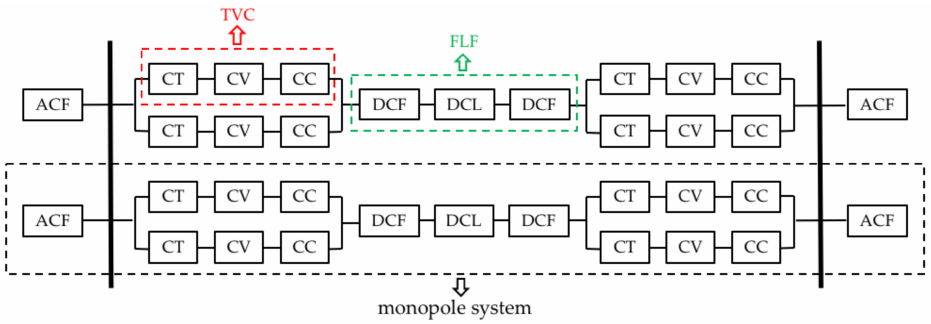
Figure 3. Reliability topological structure of UHVDC